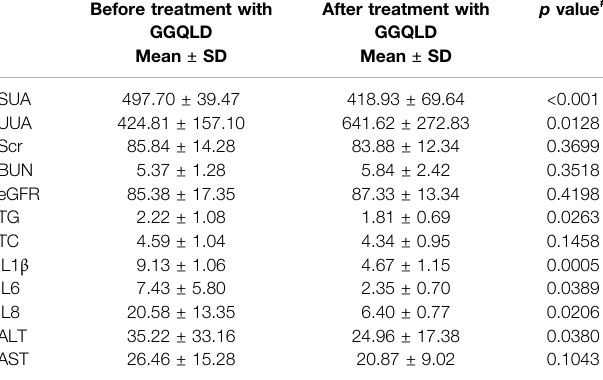
TABLE 1 | Clinical data of HUA patients before and after GGQLD treatment. Before treatment with